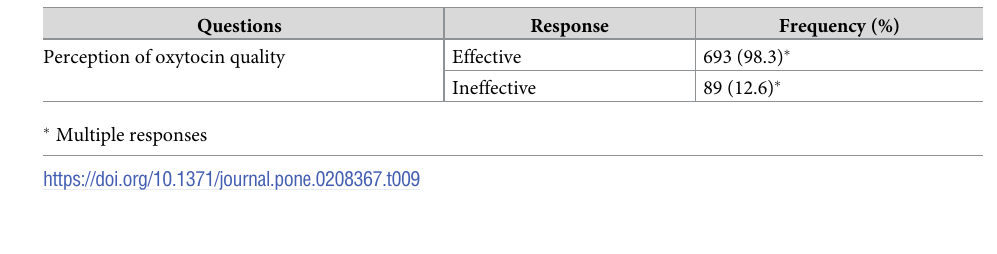
Table 9. Overall experience of effectiveness and ineffectiveness of oxytocin brands used by